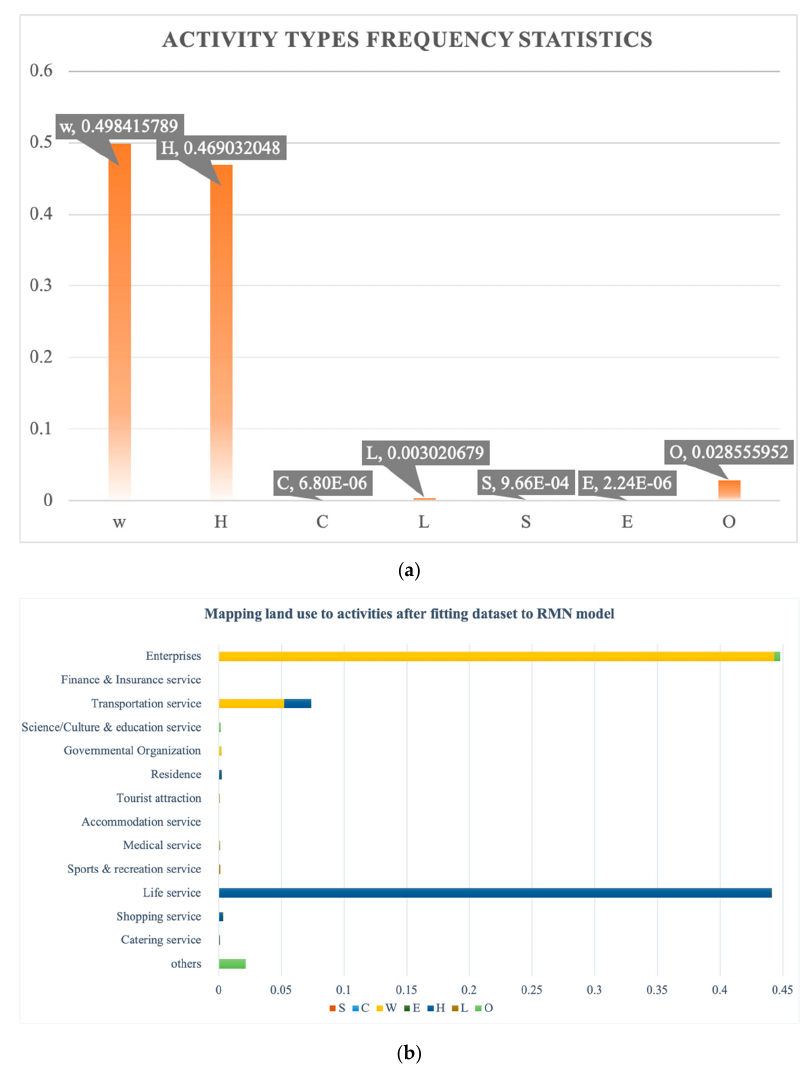
Figure 4. The statistical distribution of the RMNs activity recognition model training results. ( a ) Histogram of the proportion of various activities successfully identified. ( b ) The probability mapping relationship between land use and activity type.